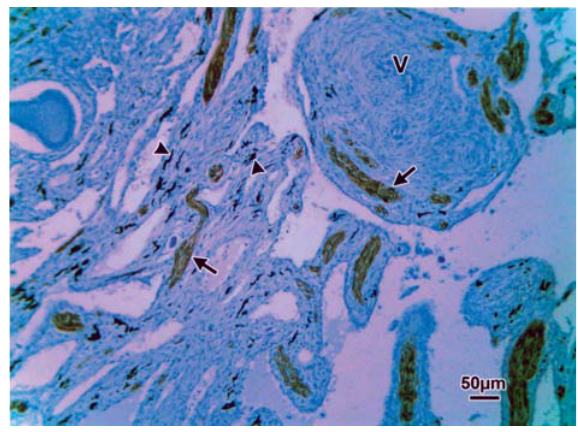
FIG. 1 NP immunoreactive nerve bundles (arrows) in the me- dulla. Some of the nerve bundles are associated with blood vessels (V). Arrowheads: melanocytes